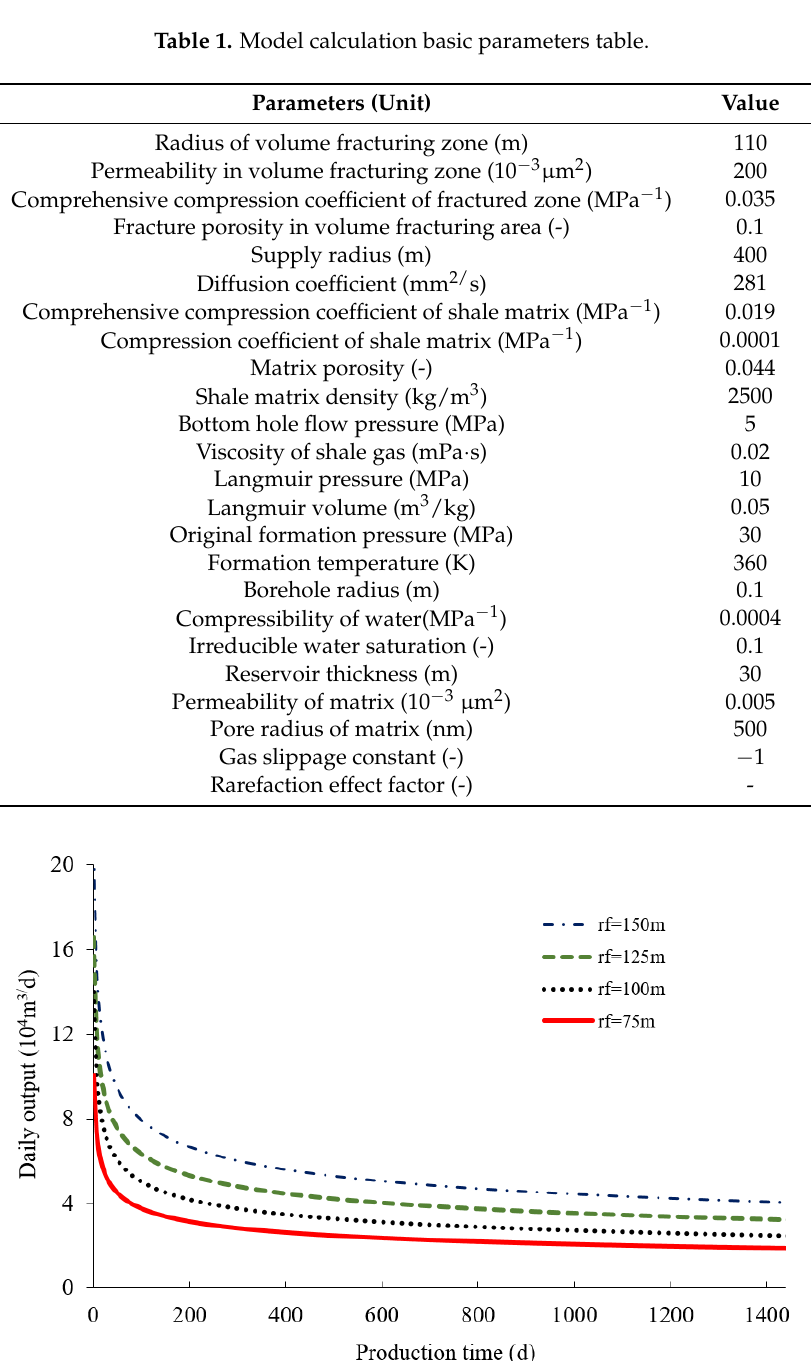
Figure 4. The influence of the radius of volume fracturing area on the daily gas production.